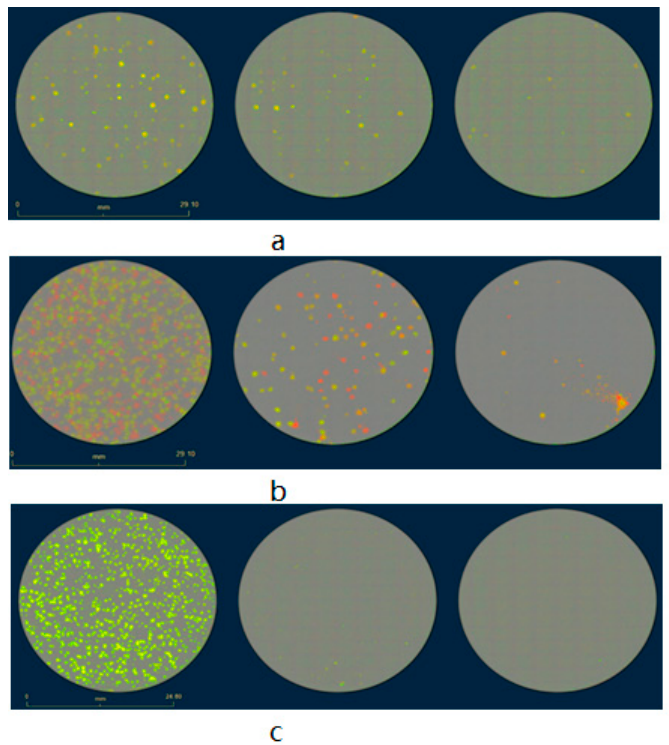
Figure 4. Isolation procedure of rVACV L1c-Ig-Turbo-TK-eGFP plaques with the fluorescence imaging system, IncuCyte ® S3. Wild-type CV-1 cells were seeded in the 6-well plates, then infected with the recombinant virus mixture from left well to right well with 10-fold serial dilution; after 36–48 h of incubation, the wells were scanned by the IncuCyte ® S3. ( a ) Plaque purification only needs to be processed with one round after picking out from a 96-well plate, scale bar = 29.10 mm. ( b , c ) Plaque purification needs to be processed with two rounds after picking out from a 96-well plate. ( b ) The first-round plaque purification, which still has many RFP-positive only plaques in the wells, scale bar = 29.10 mm. ( c ) The second round of purification. First, isolation of an eGFP-positive plaque from ( b ), then infection of CV-1 cells in a new 6-well plate with 10-fold serial dilution, scale bar = 24.80 mm.